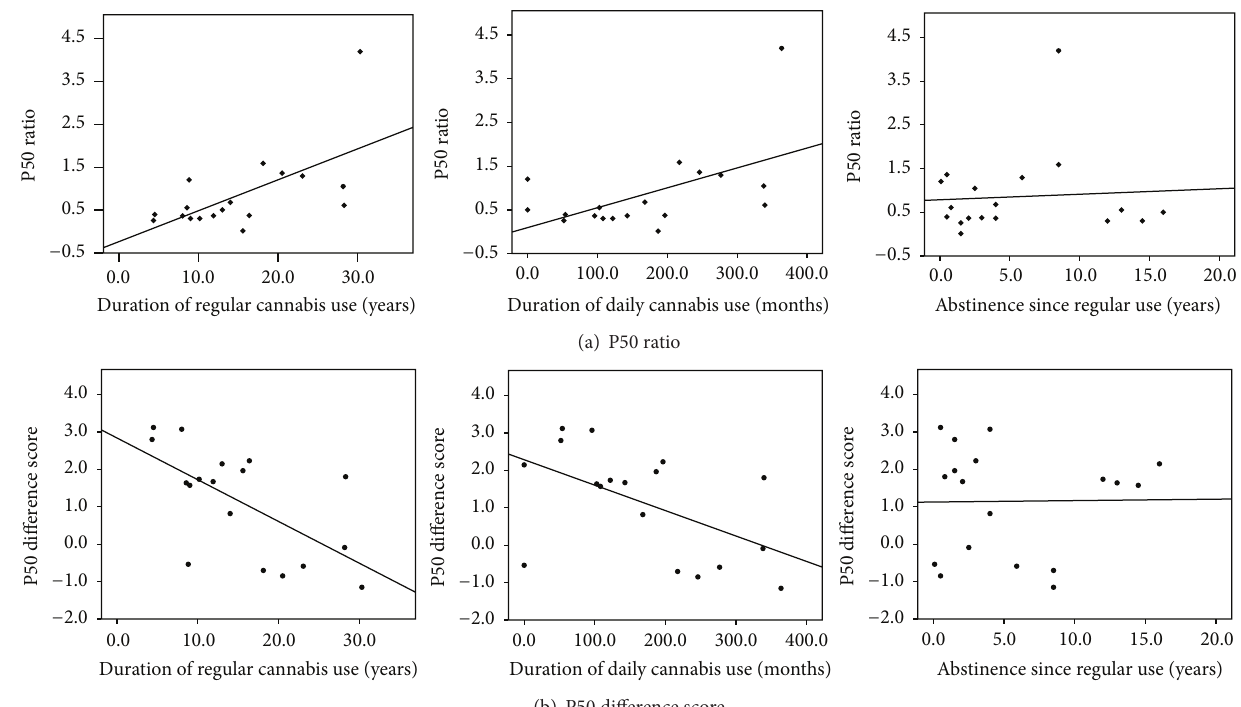
Figure4:ScatterplotsshowingassociationbetweenP50metricsanddurationofregularcannabisuseinyears(left),durationofdailycannabis use in months (middle), and duration of abstinence since regular use (right) for ex-cannabis users. P50 ratio shown on the top row (a) and P50 difference score shown on the bottom row